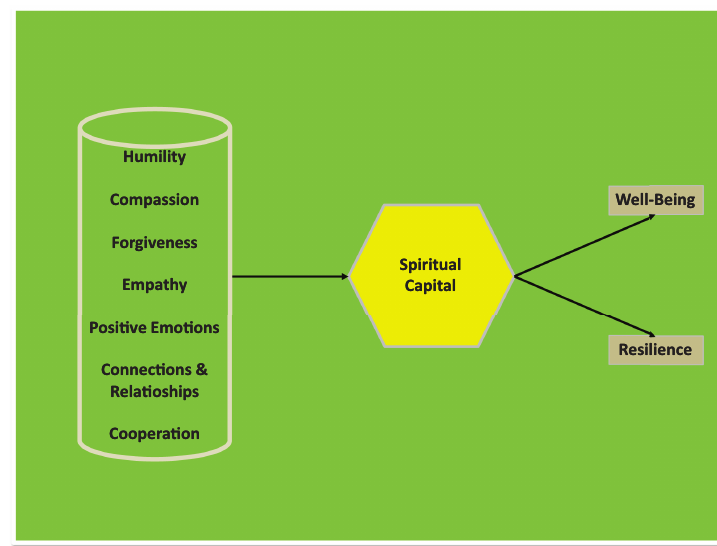
Figure 1. Conceptual model of spiritual